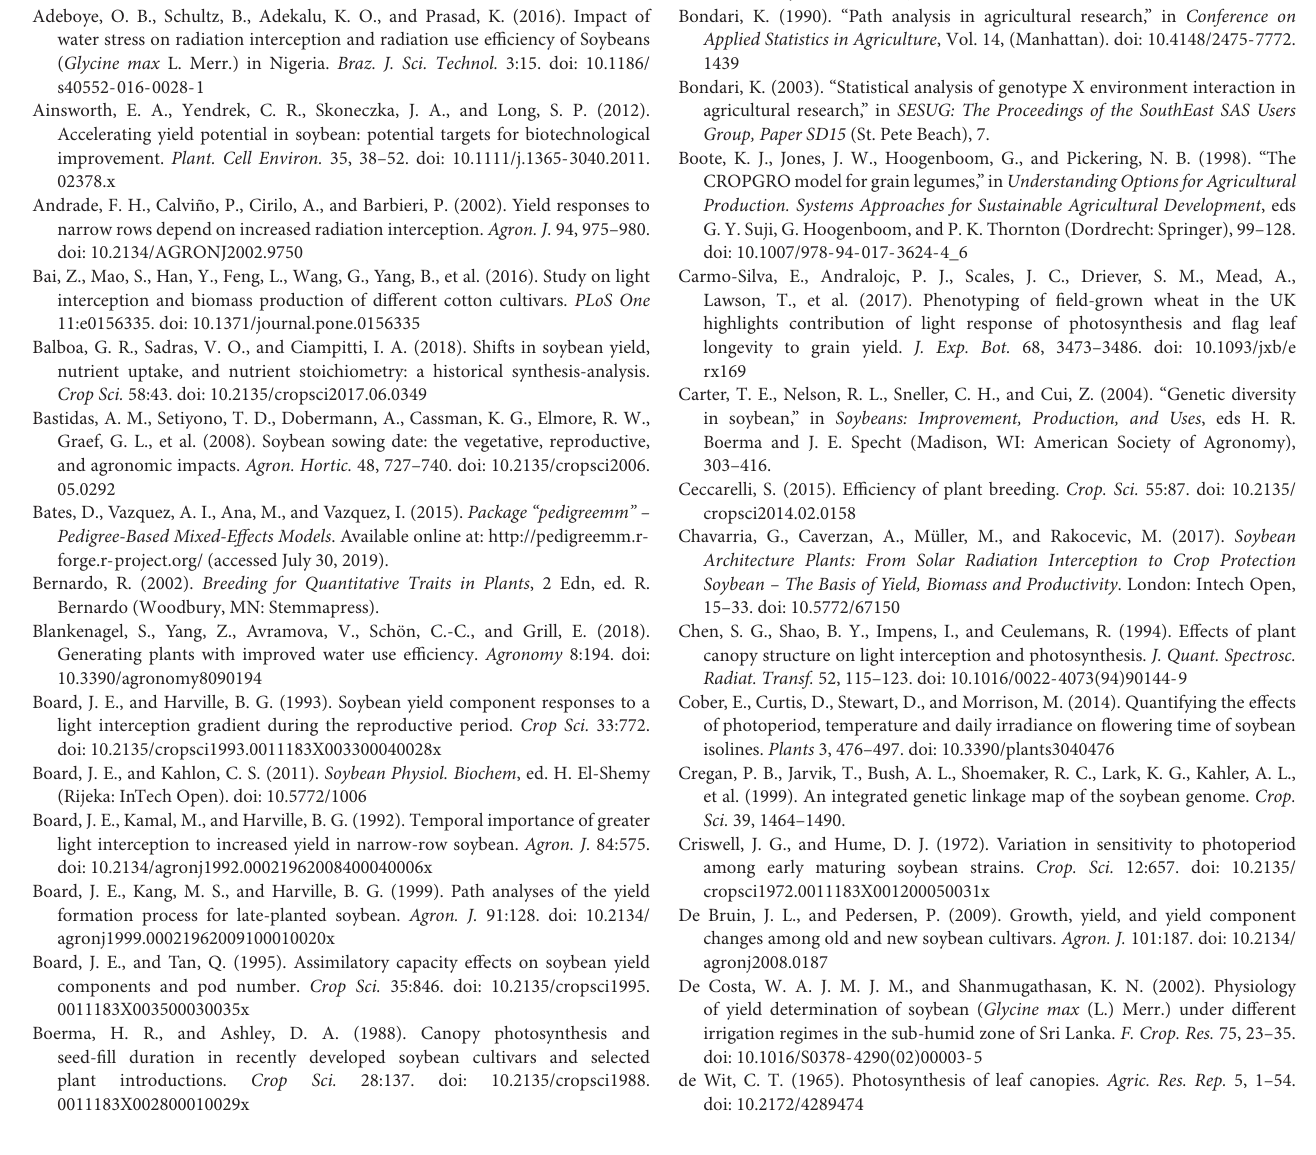
family and class.